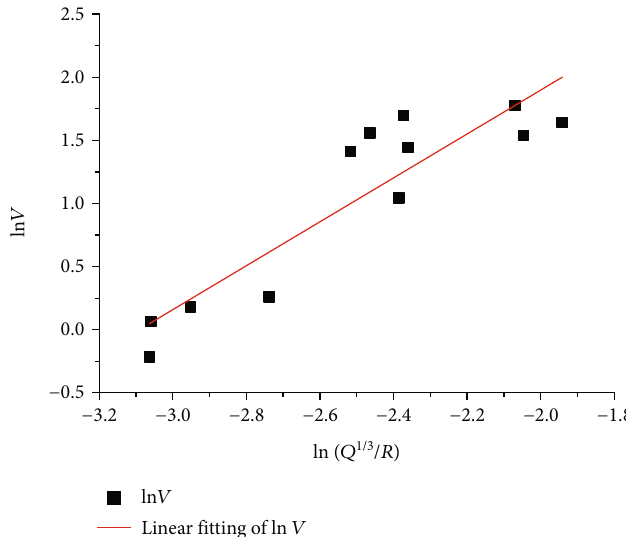
Figure 5: Decay regression line of blasting